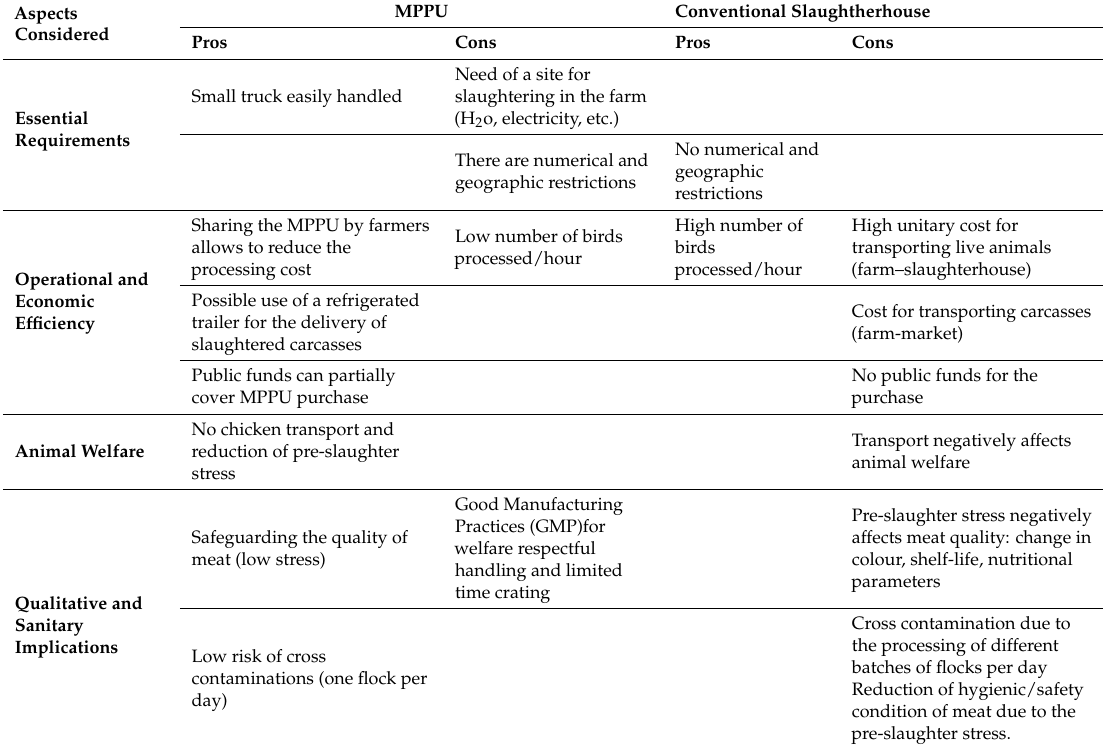
Table 1. Main characteristics of Mobile Poultry Processing Unit vs. conventional